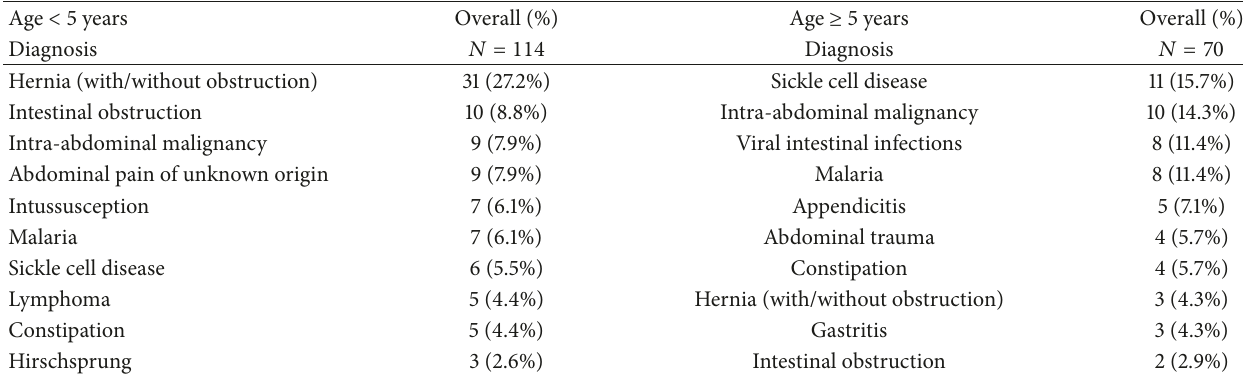
Table 3: Most common ED provider’s diagnoses.